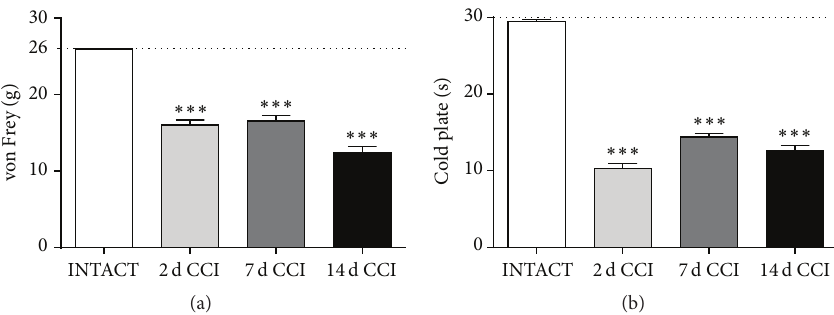
Figure 1: Levels of allodynia ((a); von Frey’s test) and hyperalgesia ((b); cold plate test) measured on 2nd, 7th, and 14th days after chronic constriction injury (CCI) in rats. The data are presented as the mean ± SEM (11–25 rats per group). Intergroup differences were analyzed usingone-way ANOVA followed by Bonferroni’smultiplecomparisonstest. ∗∗∗ 𝑝 < 0.001 indicates a significant differenceversustheINTACT